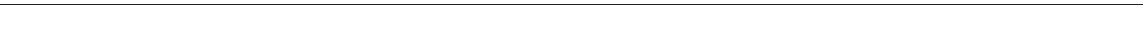
Fig. 5 Conversion of wound macrophages to fi broblast-like cells require miR-21. a MDM were polarized to pro-in fl ammatory M1 with LPS and IFN γ . Treatment of polarized MDM (CD68 + , red) with fl uids from either healing wounds (heal hi ) or non-healing wounds (heal lo ) for 72 h. FSP1 (green) and COL1 (blue) were determined using immunostaining, scale bar = 20 µ m. b The treatment with heal hi wound fl uid resulted in huddling. c qRT-PCR analysis of